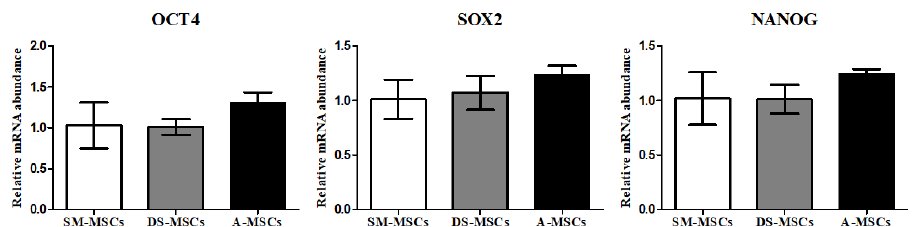
Figure 3. The expression levels of pluripotent markers of MSCs are derived from skeletal muscle (SM-MSCs), dermal skin (DS-MSCs), and adipose tissue (A-MSCs). There was no significant difference among all three types of MSCs. Data are represented by the mean ± SD of four independent experiments.